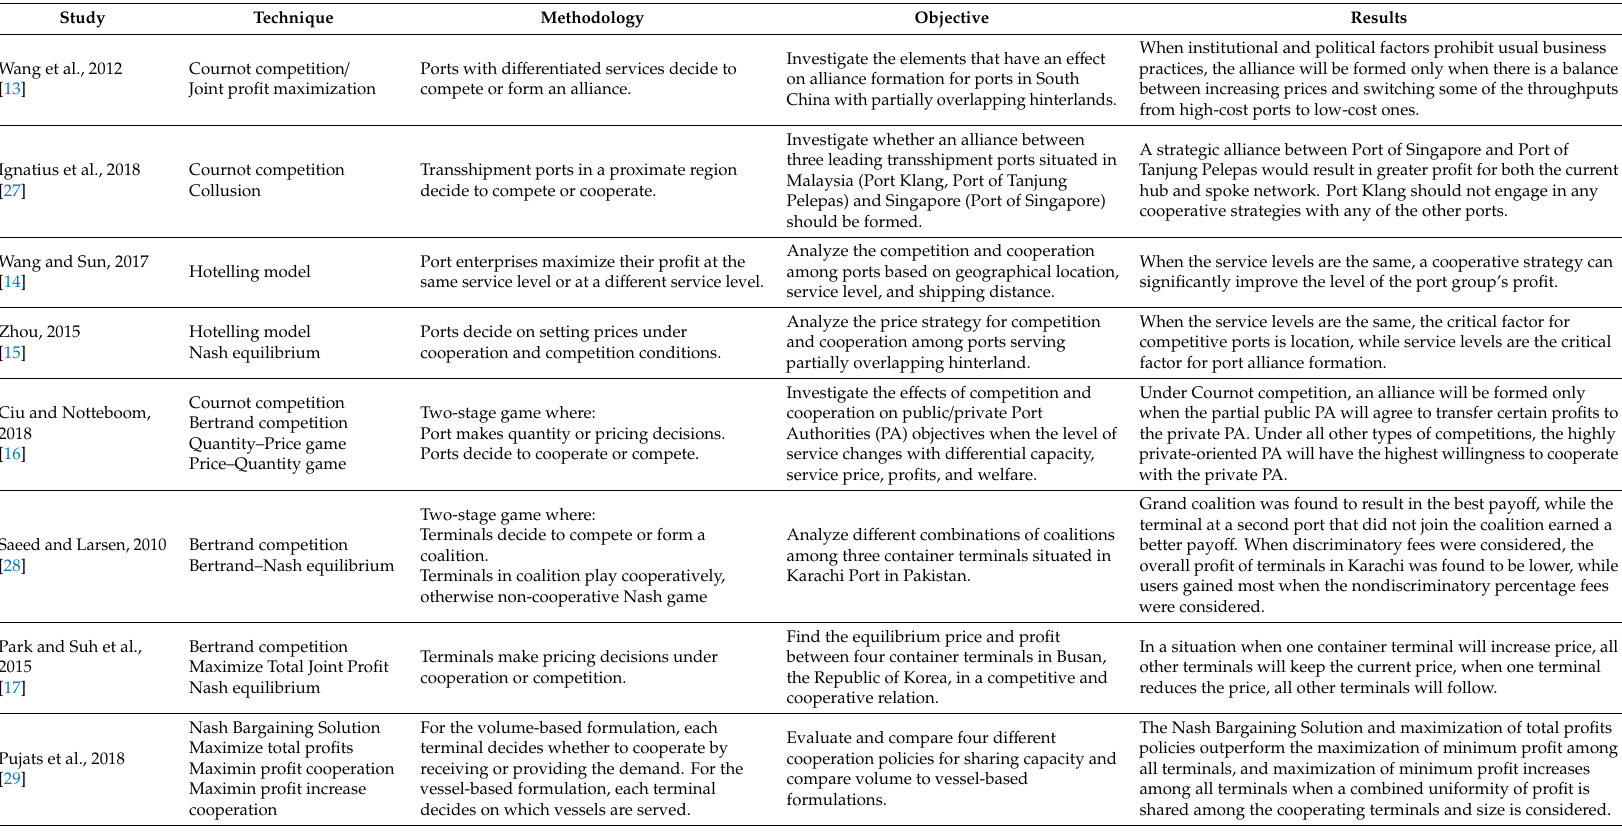
Table 1. Summary of Port and Container Terminal Cooperation / Competition and